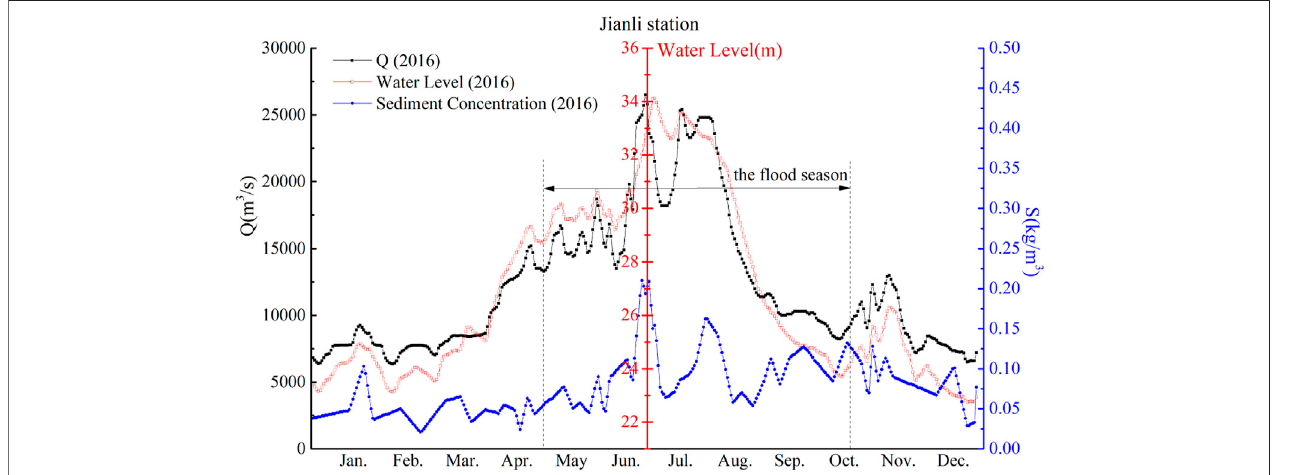
FIGURE 4 | Discharge, water level and suspended sediment concentration at Jianli hydrological station in 2016.